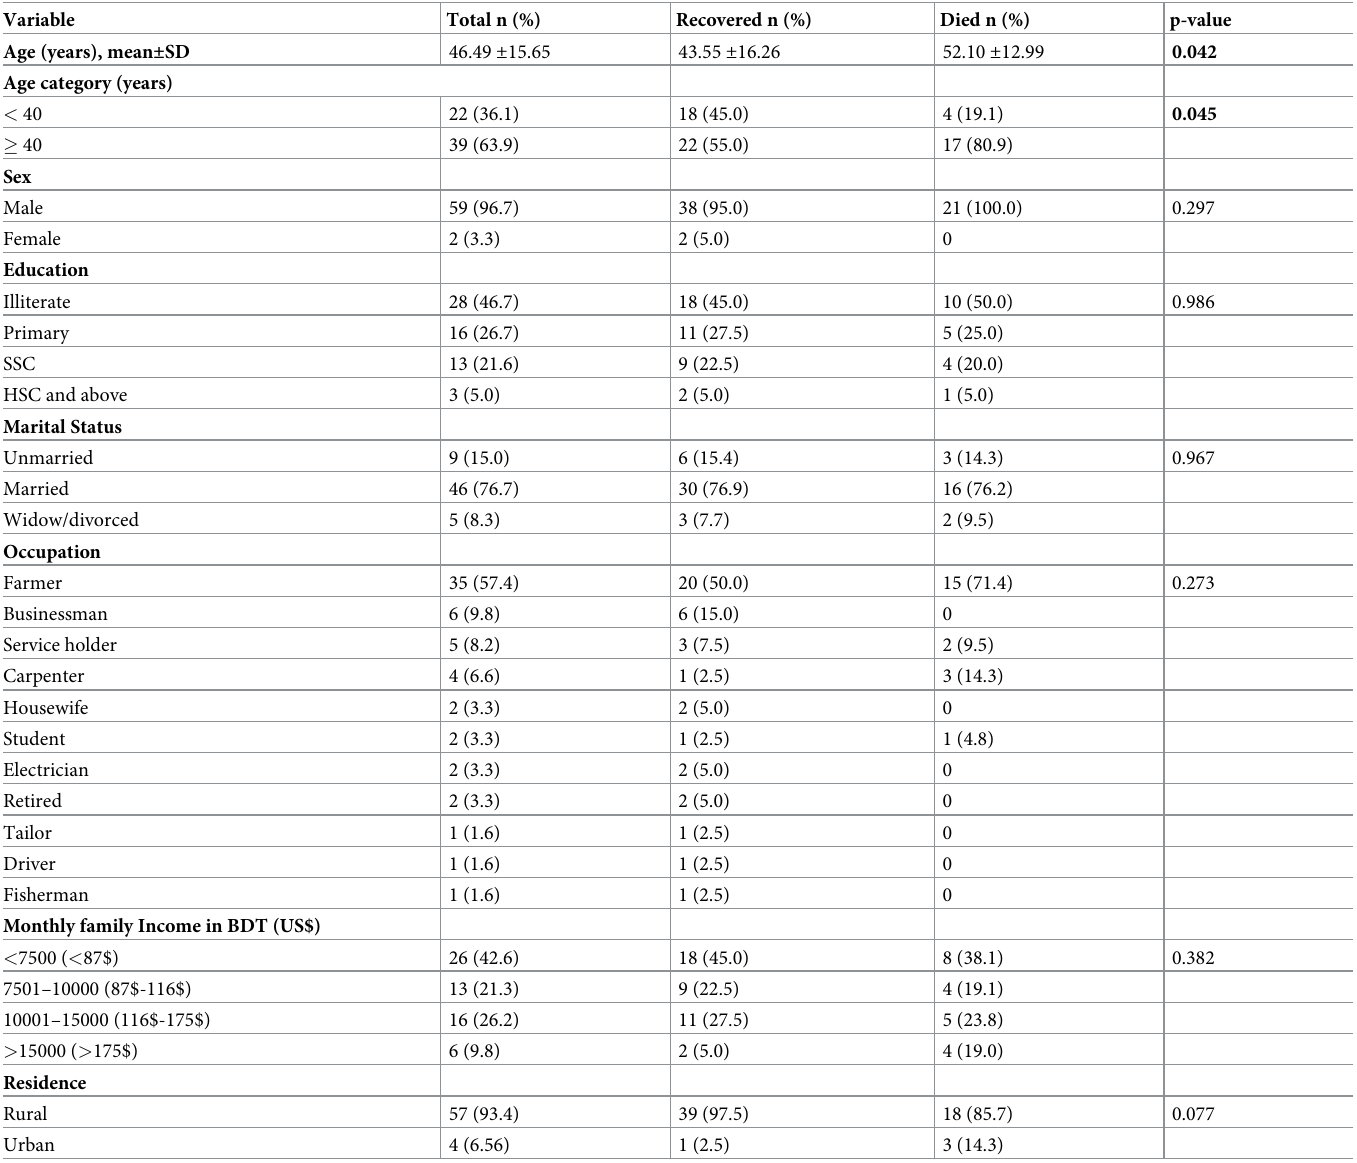
Table 1. Sociodemographic characteristics of the patients (n =